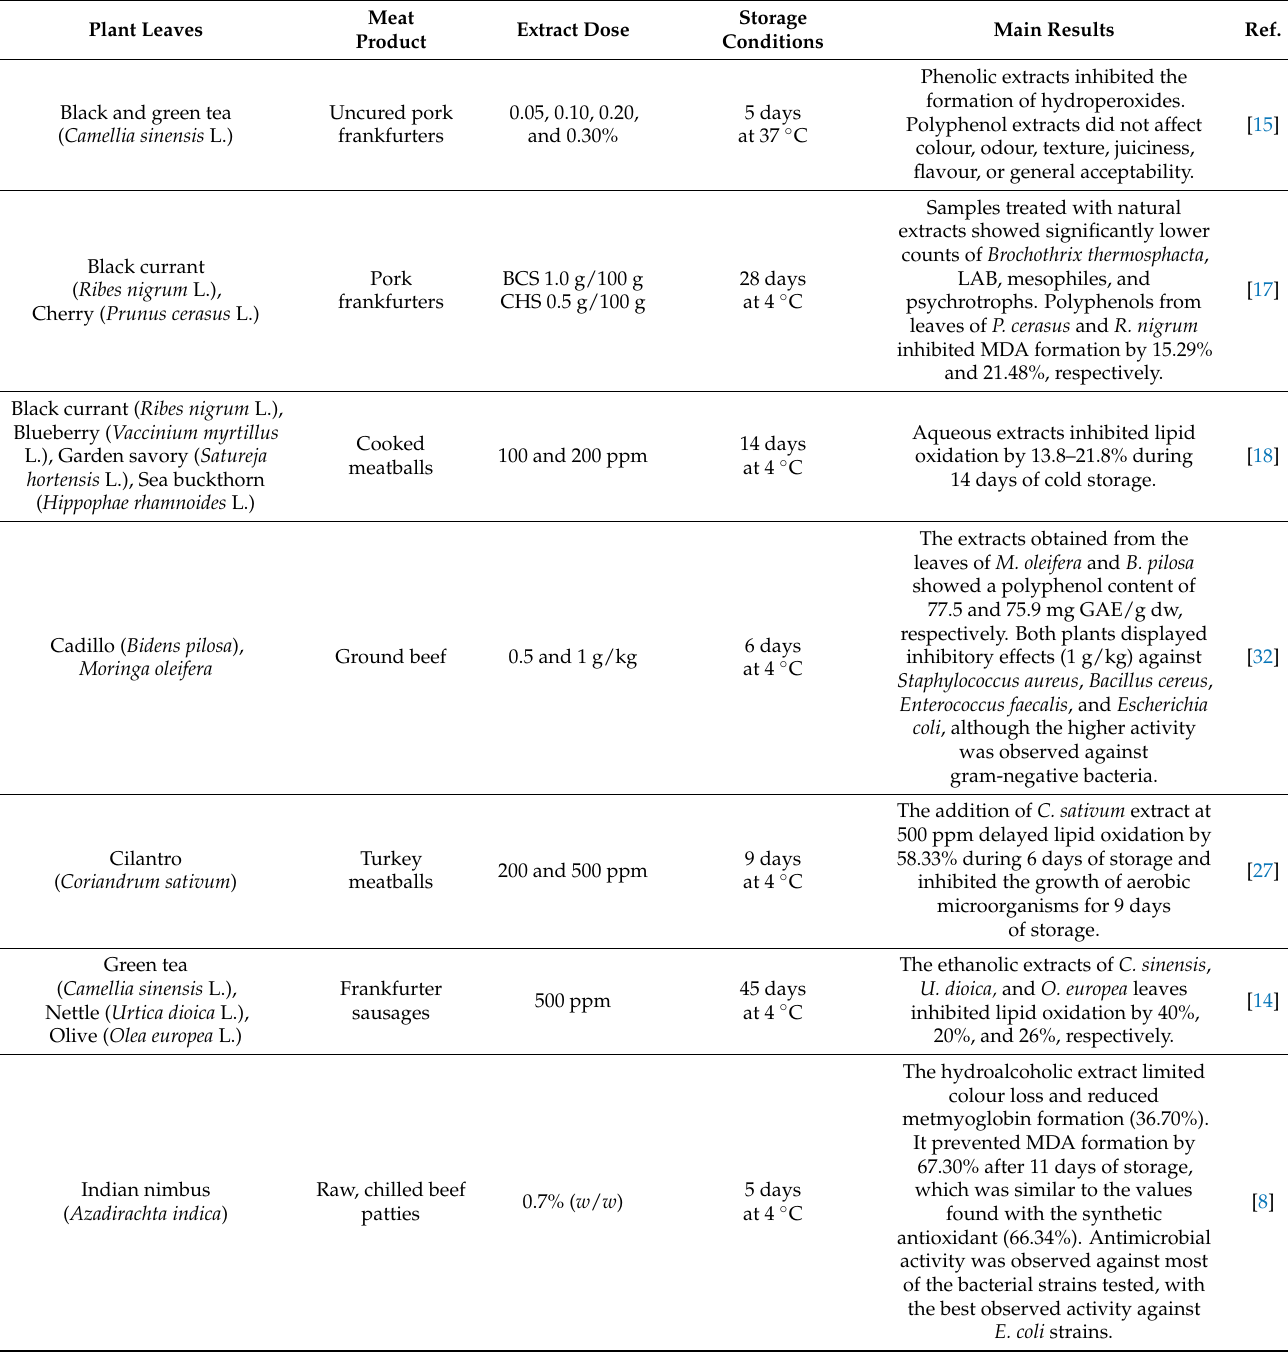
Meat Storage Extract Dose Main Results Ref. Product Conditions Phenolic extracts inhibited the formation of